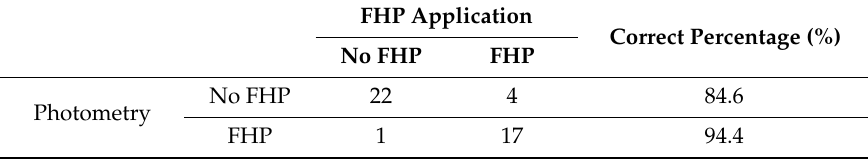
Table 4. Sensitivity and specificity (contingency